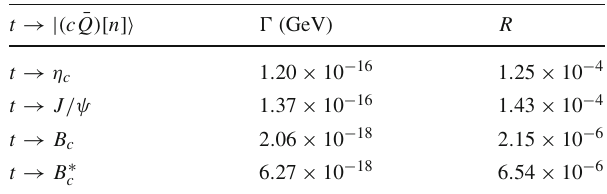
Table 1 The decay widths and the corresponding branching ratios for the ( c ¯ Q ) -quarkonium production via the channel t → | ( c ¯ Q ) [ n ](cid:5)+ Q + /(cid:2) Z 0 . The ratio R = (cid:2) t → cZ t →| ( c ¯ Q ) [ n ](cid:5)